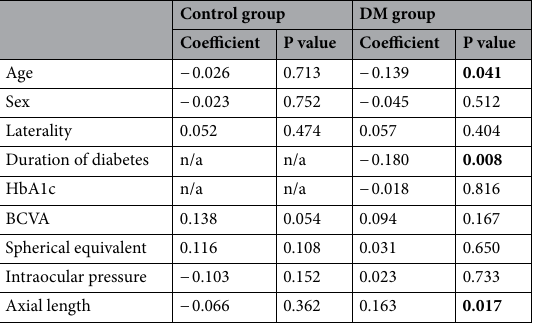
Table 4. Correlation analyses between the mean retinal nerve fiber layer thickness/vessel density ratio and various factors. Significant values are in bold. BCVA best-corrected visual